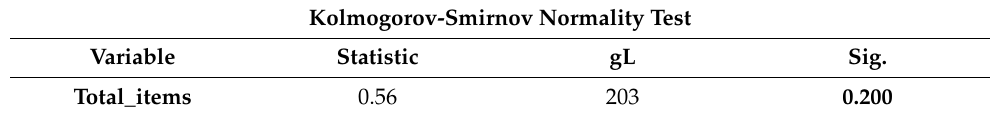
Table 1. Kolmogorov-Smirnov normality test for samples with N > 50.